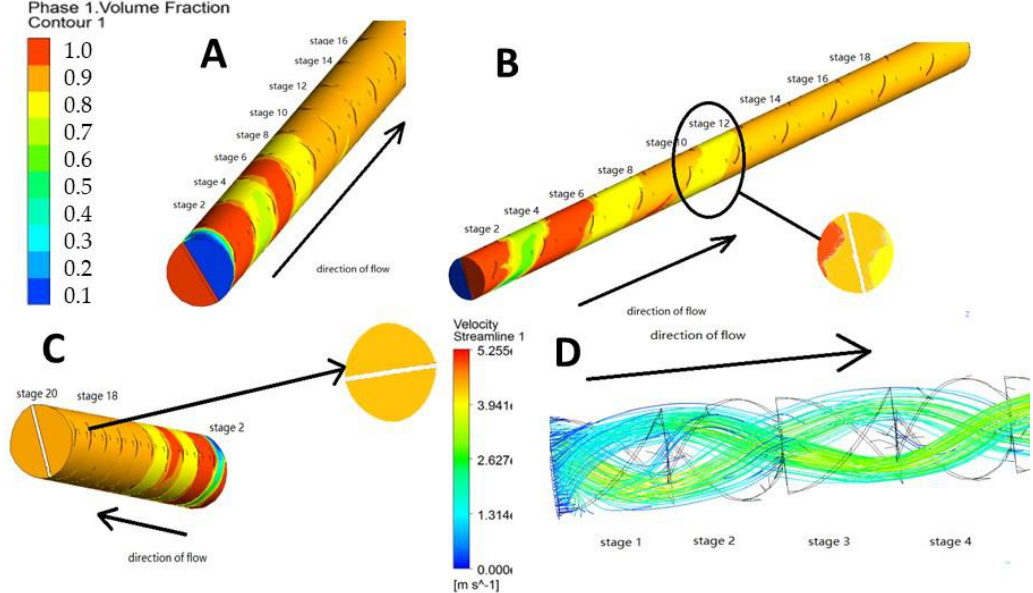
Figure 4. Results of simulations combining blood and reagent solution. ( A ): View from the entrance of the mixer showing volume fraction of the phases (blood phase in red, reagent phase in blue). ( B ): End-to-end view of blood phase volume fraction as a function of mixing stage showing center cut at stage 10 where mixing is not complete. The 83% blood volume complete mix is shown as orange (see color scale). ( C ): View from downstream end showing blood volume fraction in cross sections at the outlet and stage 18 where mixing is complete. Homogeneous orange distribution is consistent with 83%/17% V/V complete blend of blood with reagent. Beyond stage 16, the reagent phase is a constant 17%. ( D ): Velocity stream lines within the static mixer stages near the inlet. Lower volumetric flow rate of the reagent phase is seen as dark blue streamlines at the inlet (see color scale), but it does not stagnate. Beyond stage 16, streamline velocities are very similar, at about 2.6